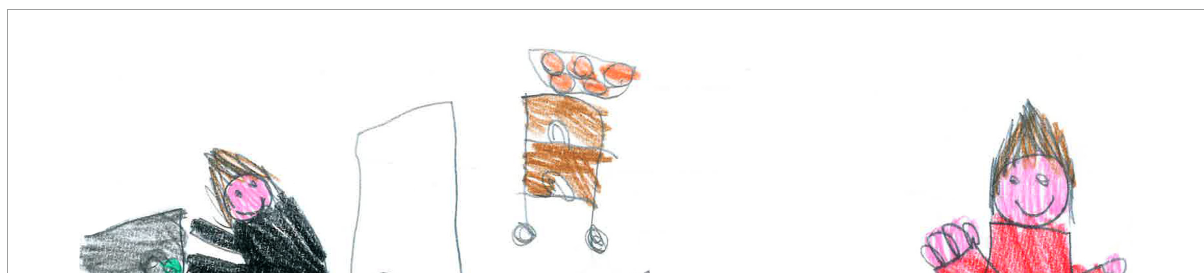
Figure 1 is an example of sharing positive emotions. It depicts a couple of children playing outdoors with a pet.